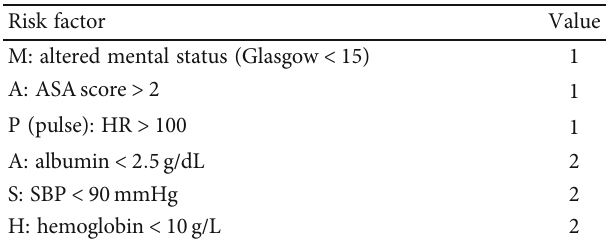
Table 2: The MAP(ASH) score.